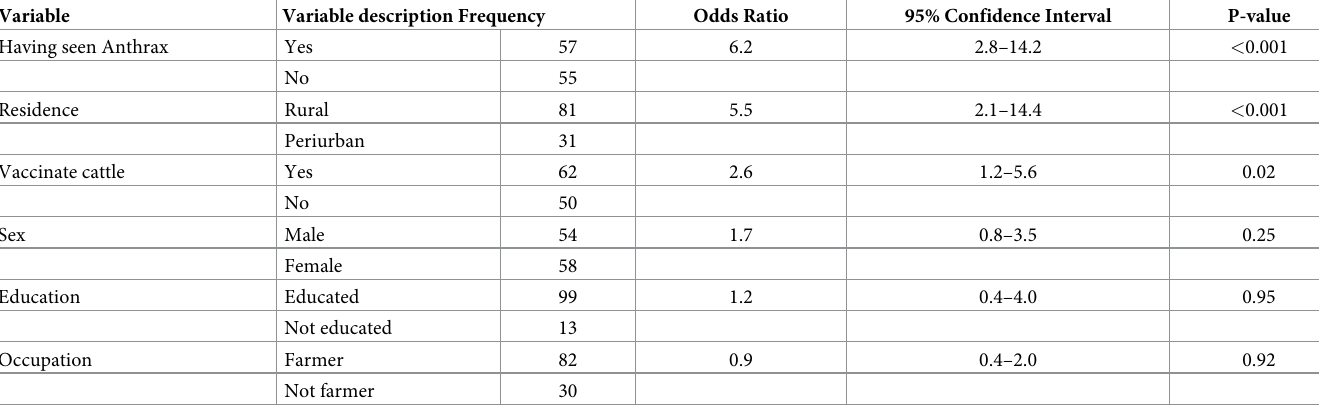
Table 4. Factors associated with having knowledge regarding anthrax, Kisumu East Sub County, July 2019 (n = 112). Variable